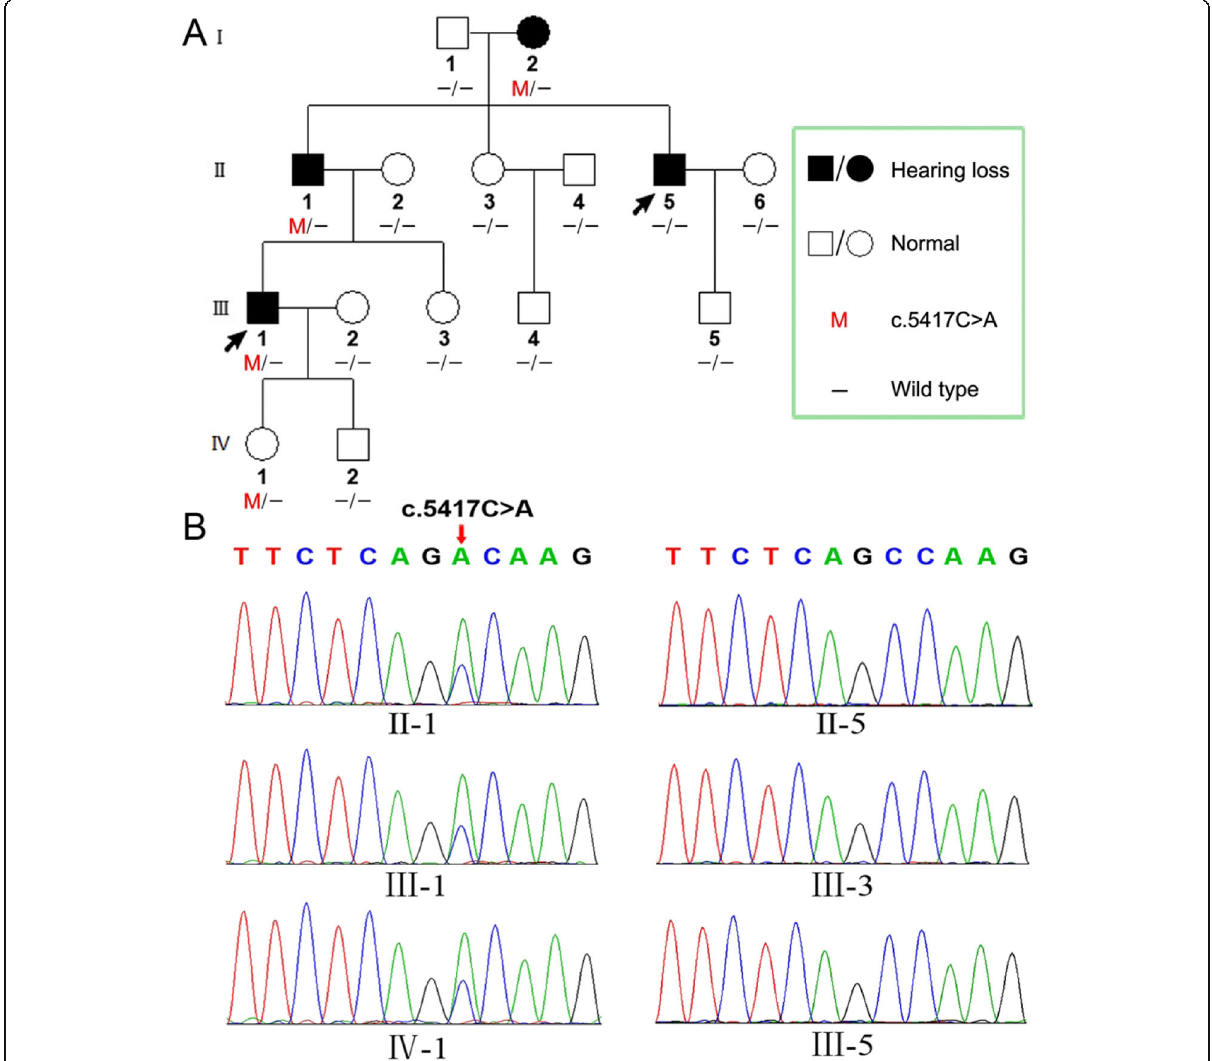
Fig. 1 a The genealogical tree of the Chinese pedigree. The probands are indicated by arrows. b the DNA sequencing profile shows the c.5417C> A mutation in the MYH14 in II-1, III-1 and